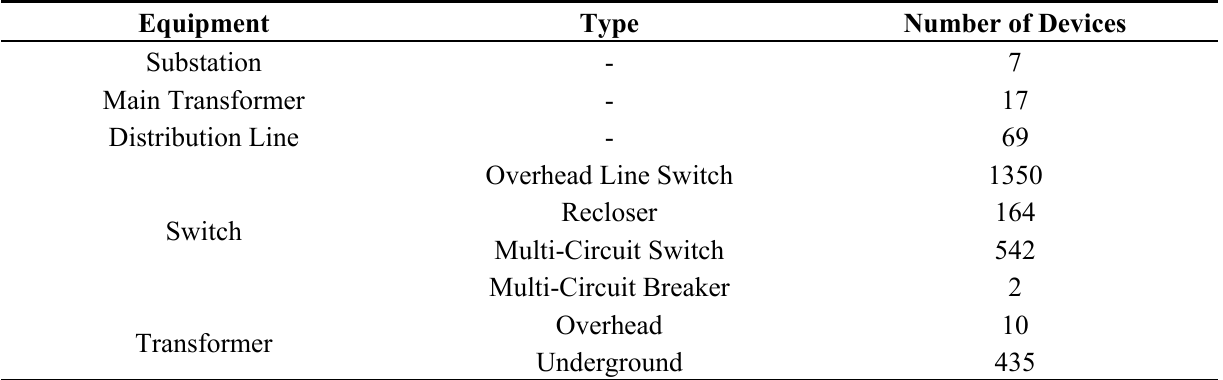
Table 4. Equipment statistics of test